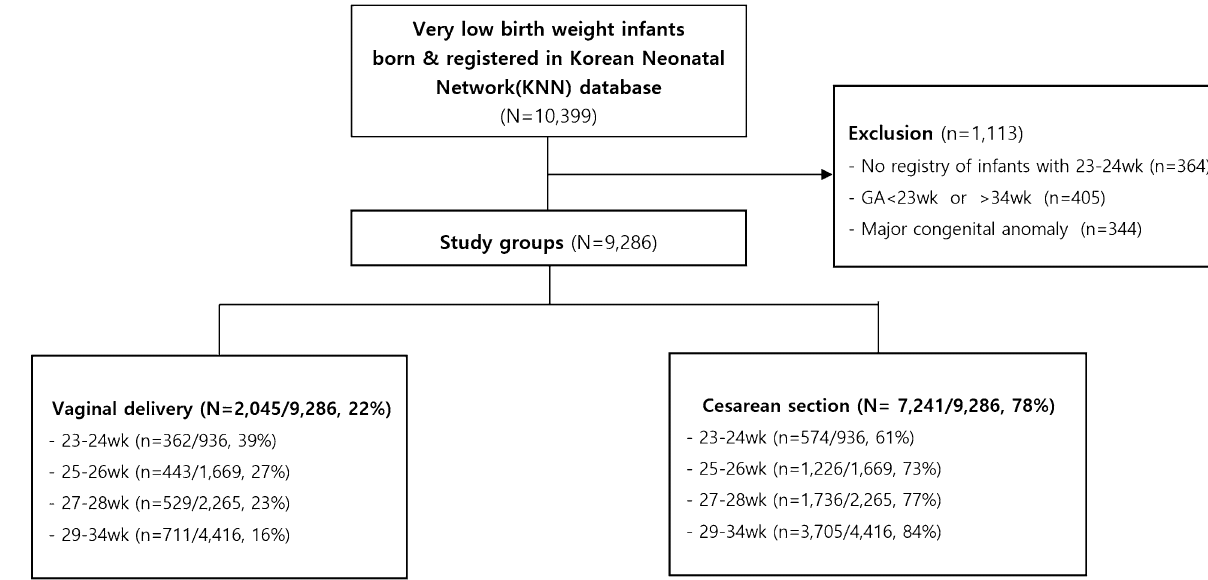
Figure 1. Flowchart outlining the study population. This study enrolled 10,399 VLBWIs. We excluded 1113 infants, and these infants were categorized into two groups based on the mode of delivery.